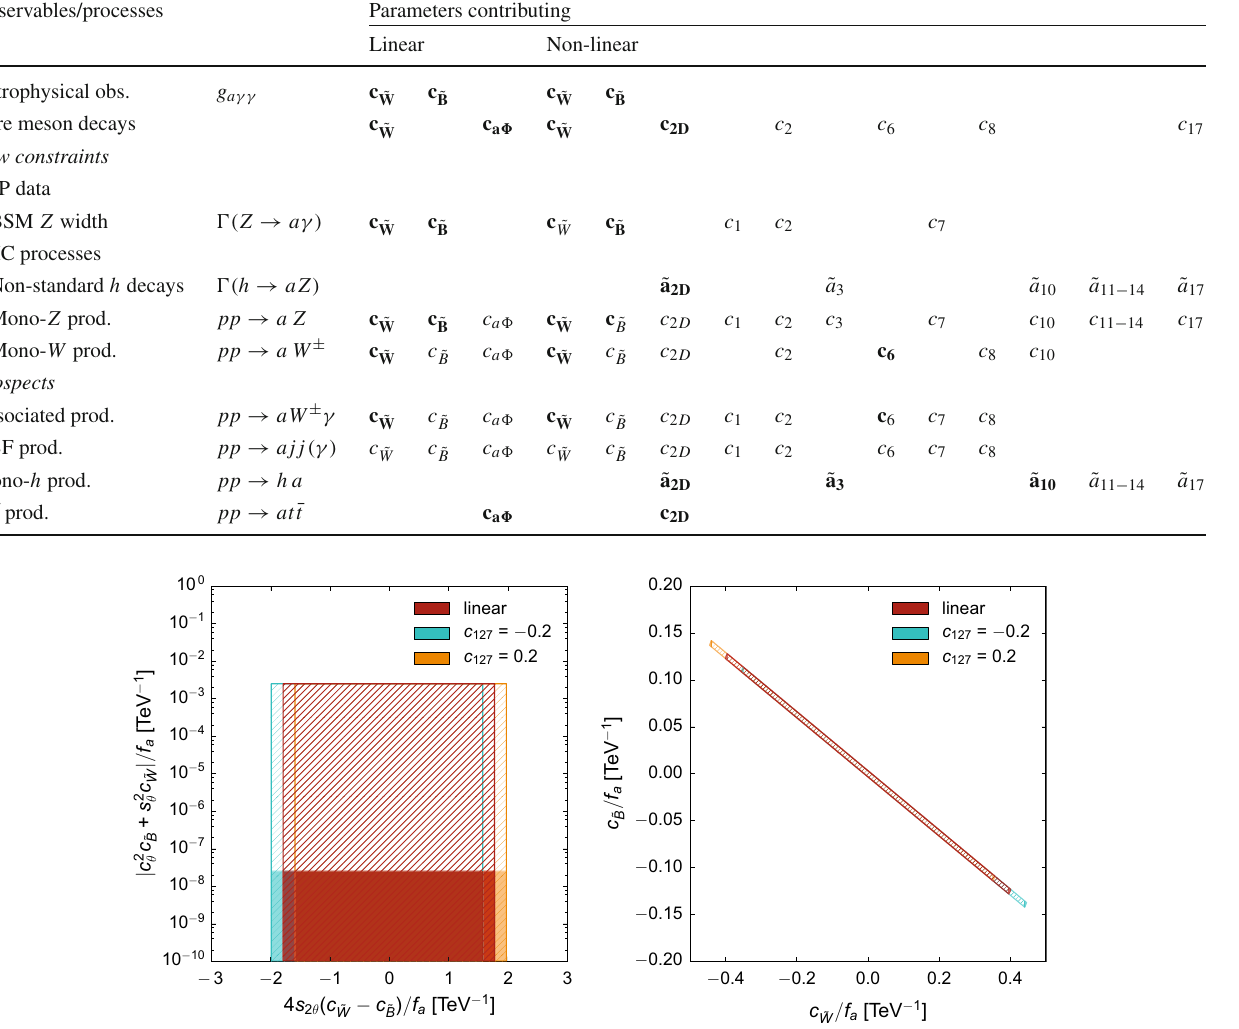
/ f / f depending on the parameter c 127 = g a and c ˜ W a derived B c 127 = 0 . 2 is about maximal, as it is obtained fixing c 1 = c 2 = c 7 = 1, typical of the strongly interacting regime. The linear case corresponds to c 127 = 0. Right The rotated figure shows only the region allowed for m a = 1MeV